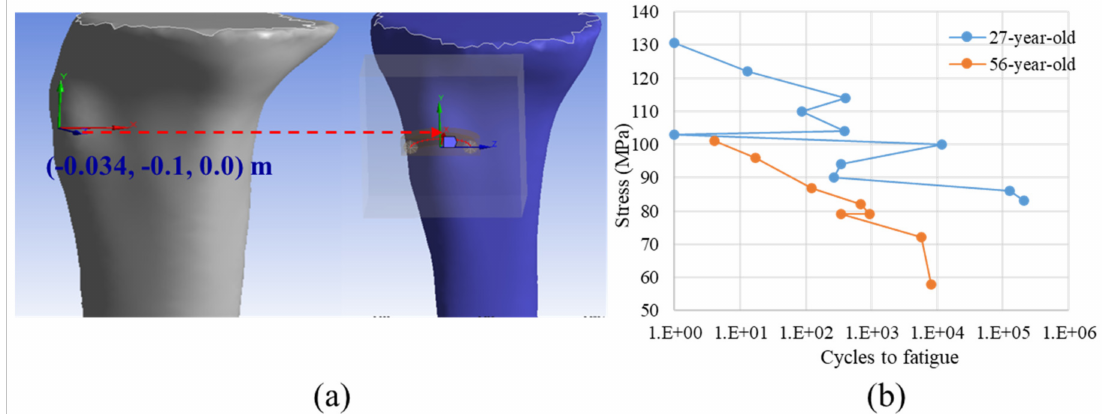
Figure 3. Location of the crack initiation based on the clinical observation ( a ) and the Stress-Cycles to fatigue diagram (the so-called SN curve) from the accumulation of fatigue micro-damage in the human cortical bone of two different ages used in the age-related critical point identification process extracted from [20] ( b ).